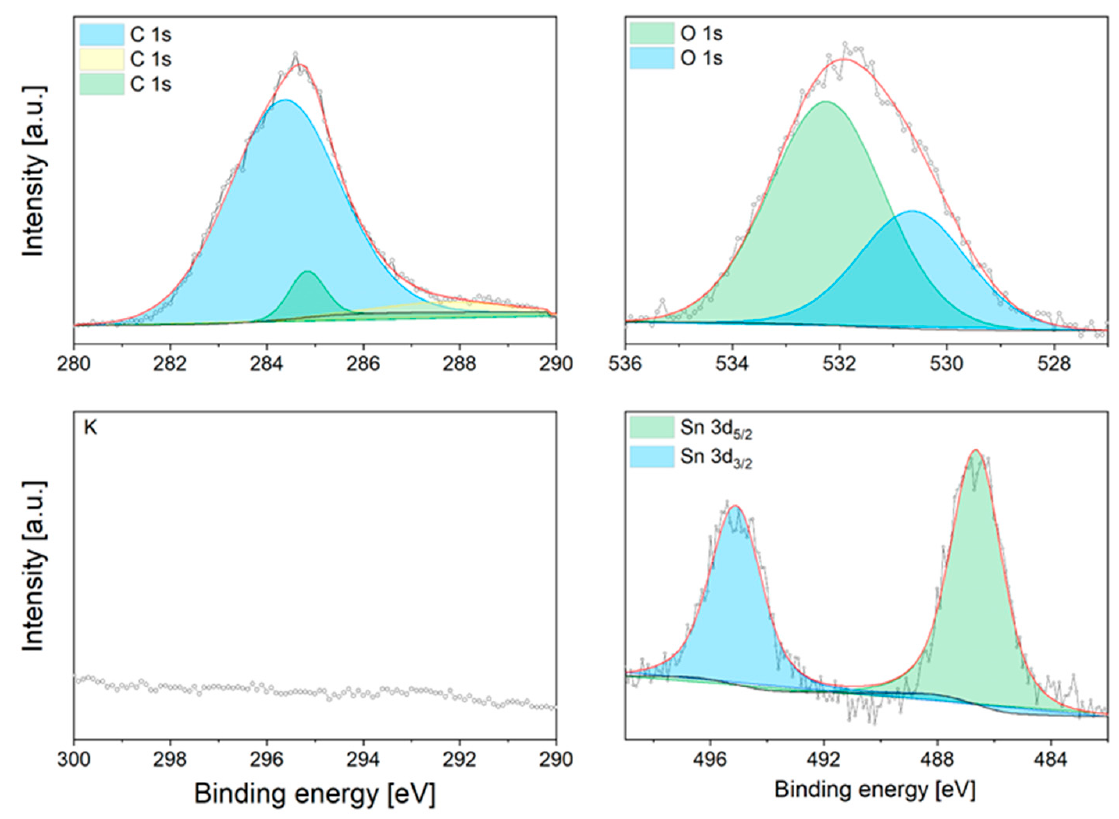
Figure A3. XPS of raw K-A.